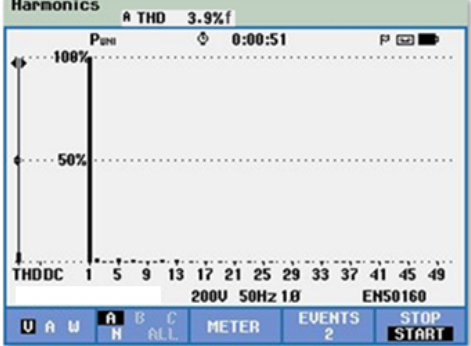
Figure 17. Grid current total harmonic distortion (THD).